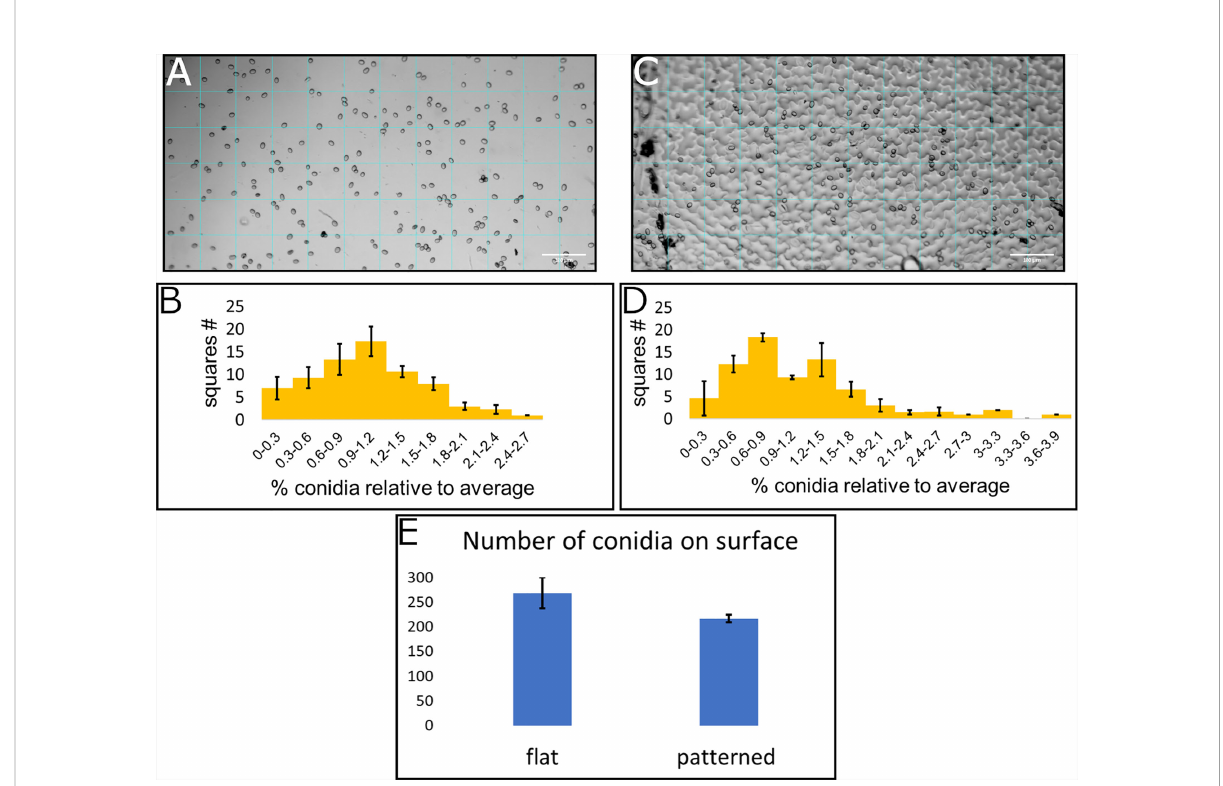
FIGURE 3 Conidia distribution on fl at and patterned surfaces. 10 m l of B . cinerea conidia suspension (10 5 conidia/ml) was applied on a fl at surface (A) and a tomato leaf replica (C) , both made from PDMS. A grid of 72 squares was applied to the microscope images ( A for fl at surface and C for patterned surface). The number of conidia was counted in each square and a histogram of number of squares with different amounts of conidia compared to the average was generated ( B for fl at surface and D for patterned surface). (E) shows the total number of conidia counted on these surfaces. Three repeats of each surface type were performed and insert into the